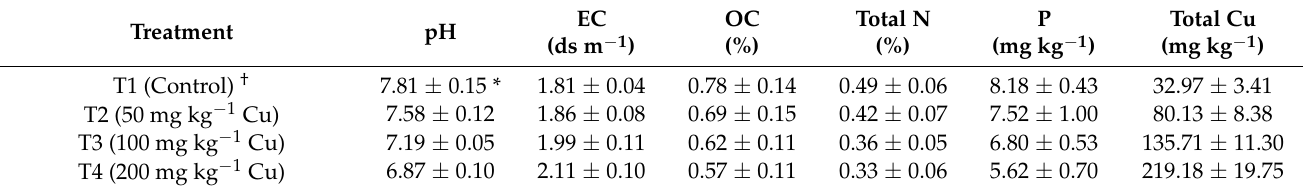
Table 1. Selected characteristics of the test soils in different phytoremediation treatments. Treatment